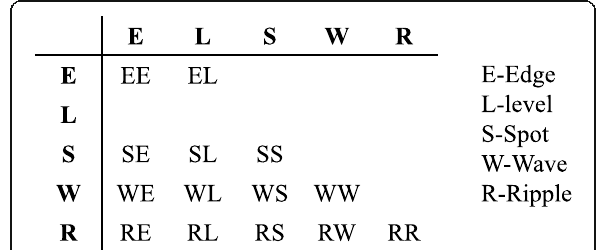
Fig. 4 Masks employed in the extraction of law ’ s texture energy measures [30]